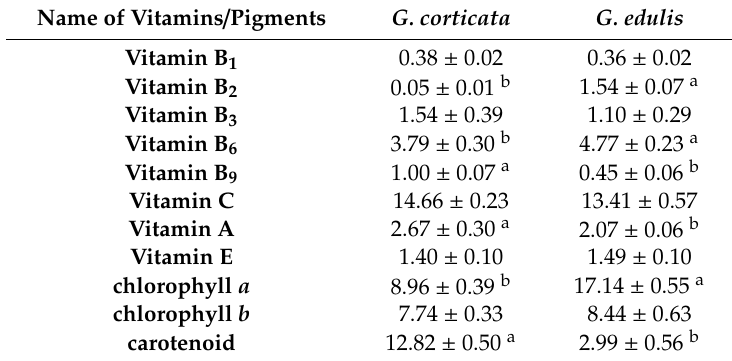
Table 5. Vitamin composition (mg / g), chlorophyll and carotenoid content ( µ g / g) of G. corticata and G. edulis .